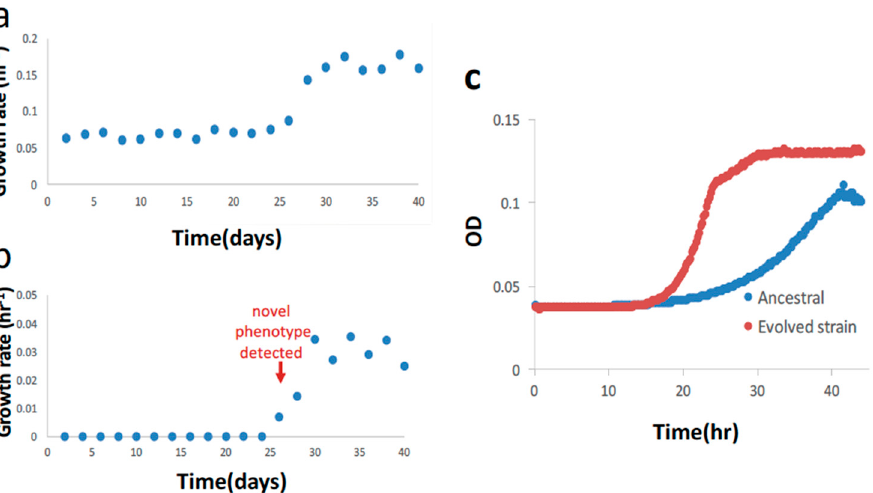
Figure 2. Results of first stage of evolution with serine. ( a ) Primary growth rate during the first stage of evolution with serine. ( b ) Secondary growth rate during the first stage of evolution with serine. ( c ) Growth curve of the evolved clone and ancestral strain. The evolved clone shows diauxic growth, with first phase growth rate of 0.16 hr − 1 and second phase growth rate of 0.0251 hr − 1 . The ancestral strain shows only one growth rate of 0.06 hr − 1 . In ( a ) and ( b ), evolution is performed with constant serine concentration 0.5 g/L.